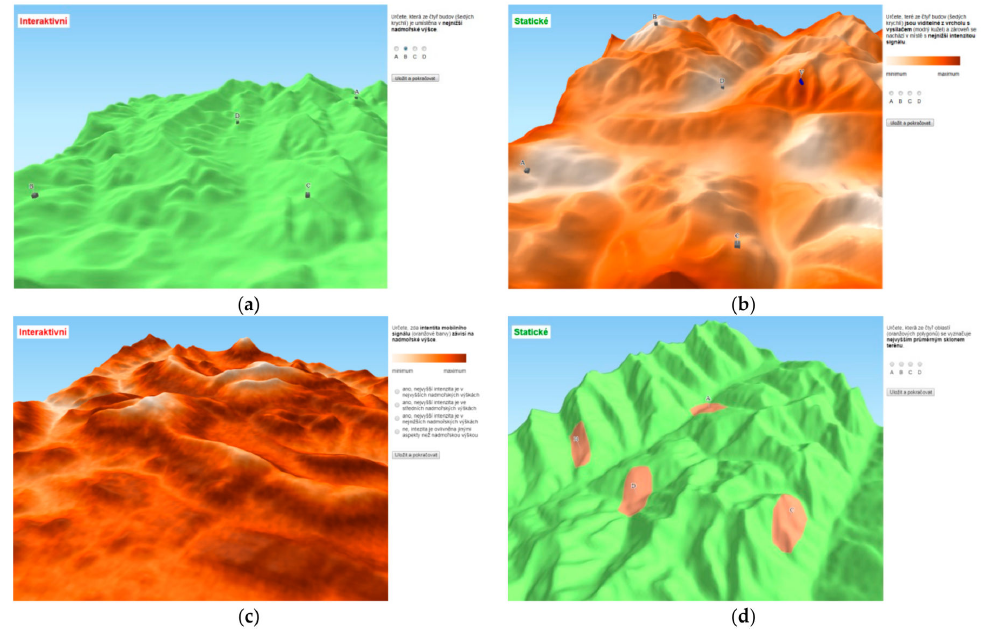
Figure 2. Examples of 3DmoveR user interface: ( a ) Task A—selecting which of four buildings is at the lowest altitude—interactive variant; ( b ) Task D—determining which of four buildings are visible from the top of the signal transmitter and are also in the location with lowest signal intensity—static variant; ( c ) Task Ea—determining whether signal intensity depends on terrain slope—interactive variant; ( d ) Task Fb—determining which of the four areas is characterized by the highest average terrain slope—static